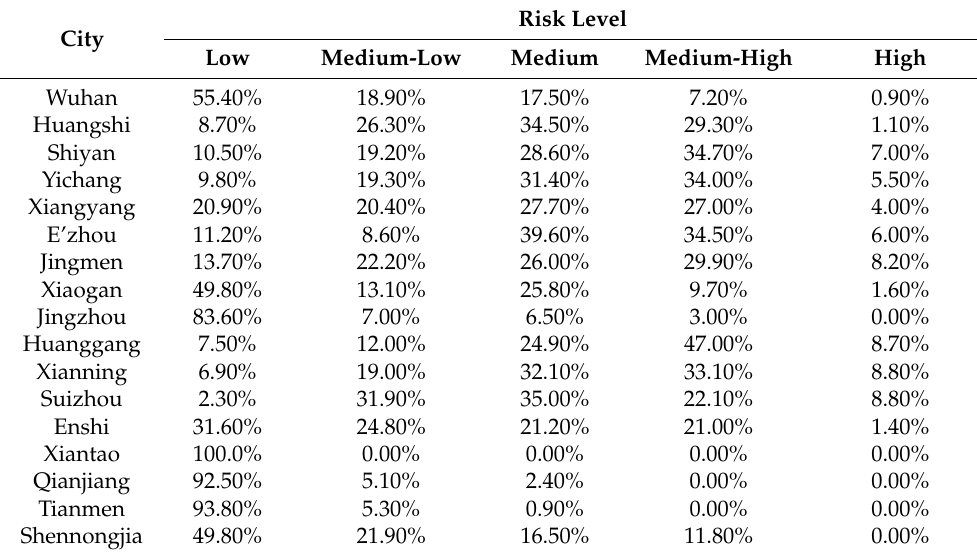
Table 14. The Proportion of Risk Areas of Different Levels in Each